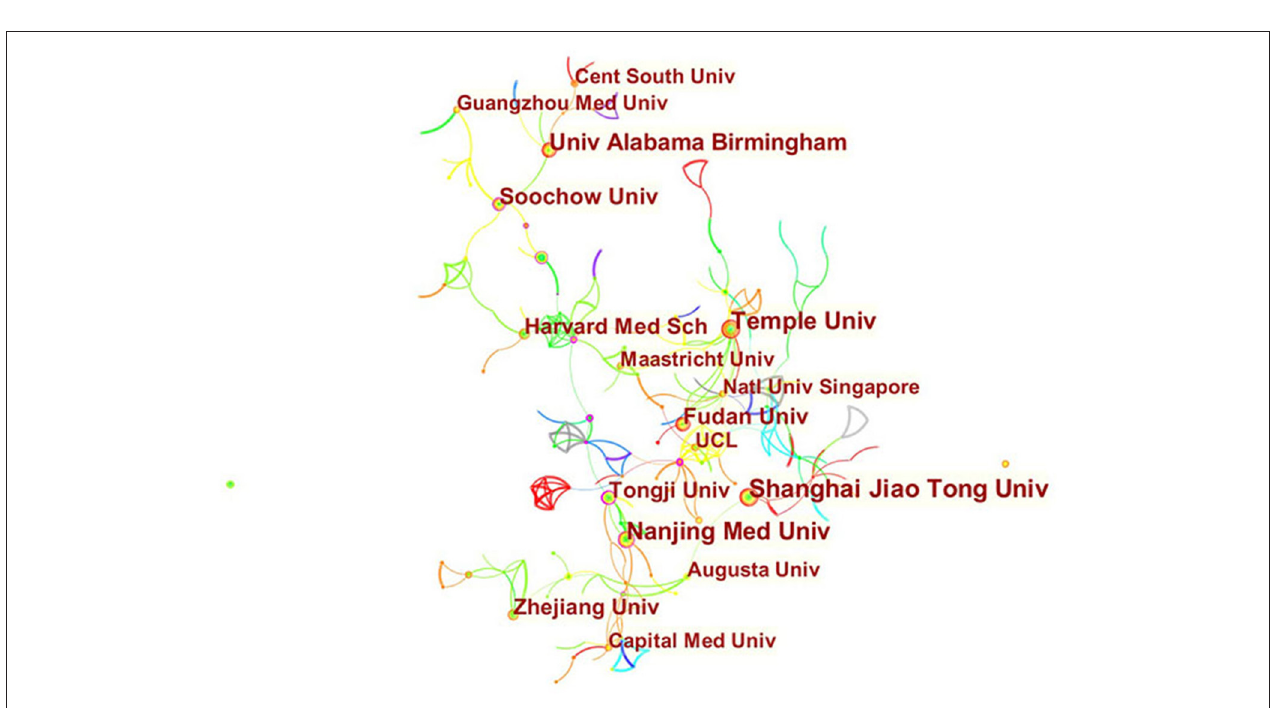
FIGURE 4 | Distribution of publications from different institutions.